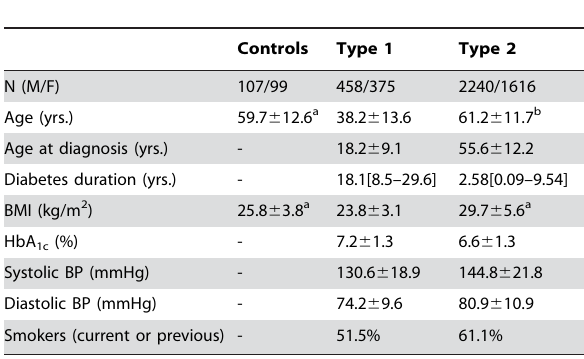
Table 1. Clinical characteristics of the patients and non- diabetic control